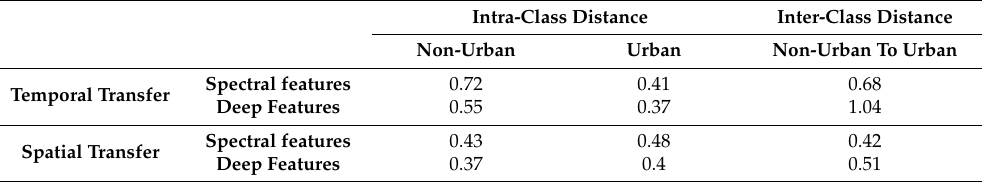
Table 4. Inter-class and intra-class distances based on original spectral features and deep